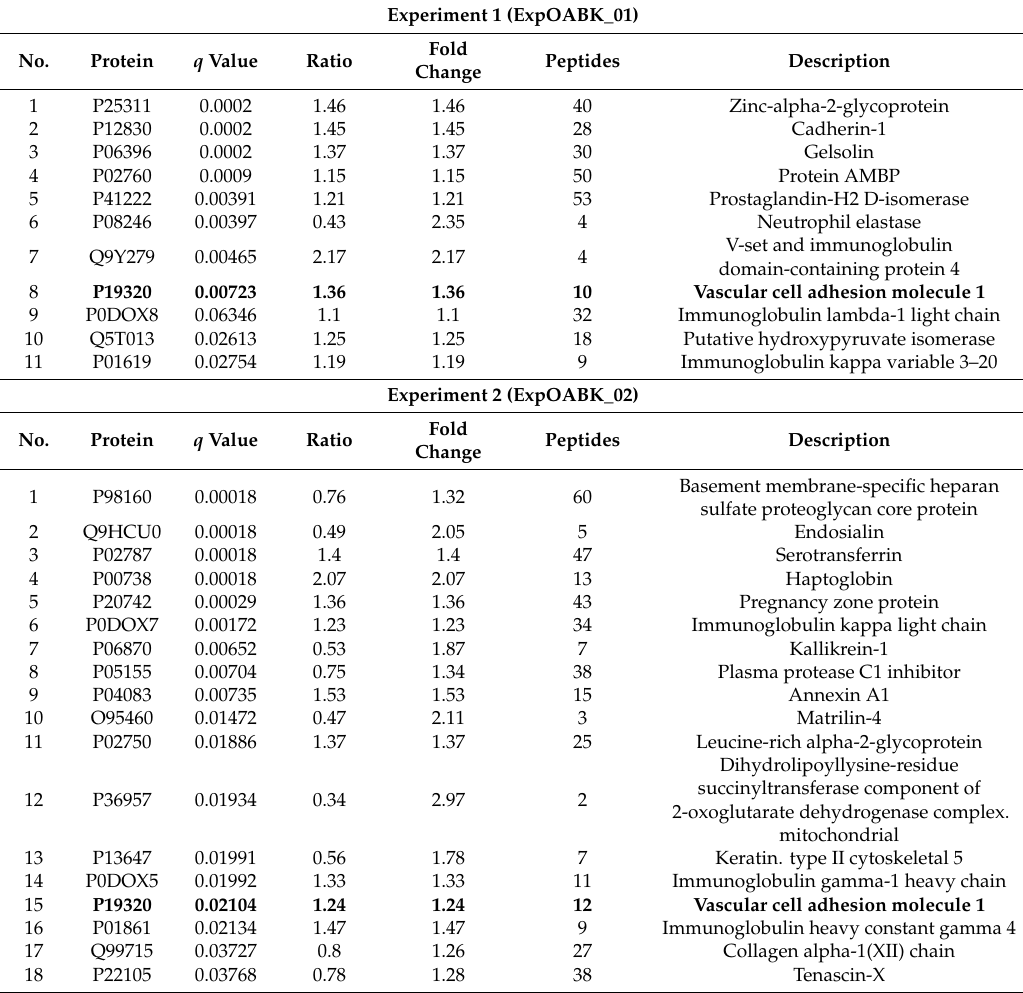
Figure 1. Results of qualitative analysis—a Venn diagram representing the number of proteins identified by two or more peptides in two biological replicates of the iTRAQ experiment. Here, 953 proteins are common to both experiments. iTRAQ, isobaric tags for relative and absolute quantification. Table 2. Qualitative and quantitative results of the di ff erential proteins in OAB vs. control group in both experiments (ExpOABK_01 and